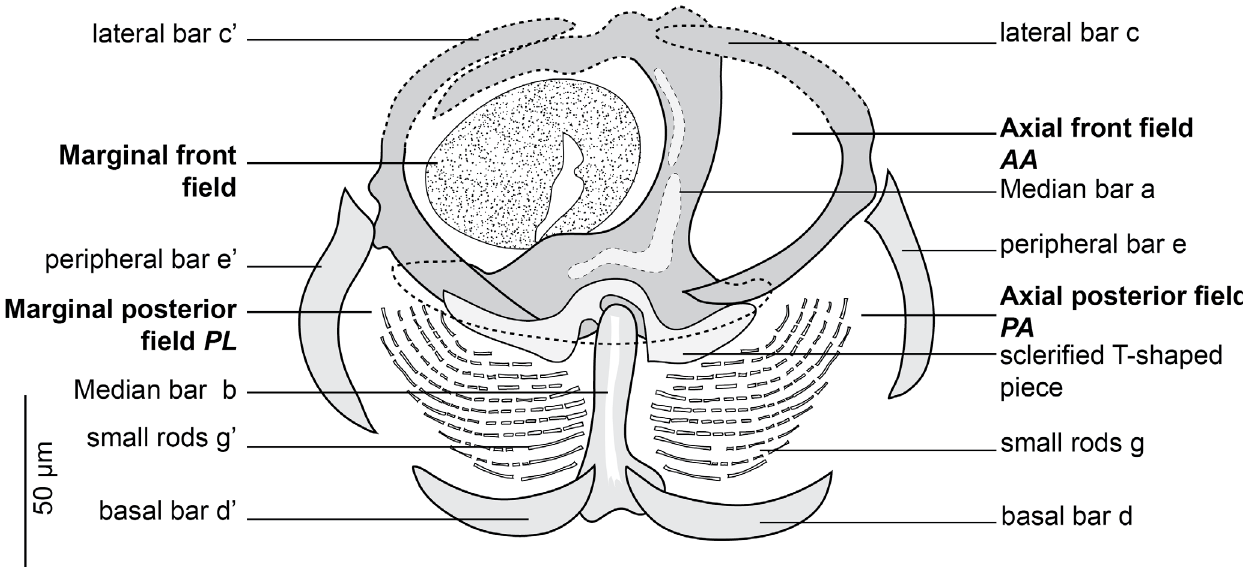
Figure 3. Clamp of Cyclocotyla bellones Otto, 1823, MNHN HEL1316. Nomenclature of the clamp sclerites as proposed by Llewellyn [60] and used by Euzet and Trilles